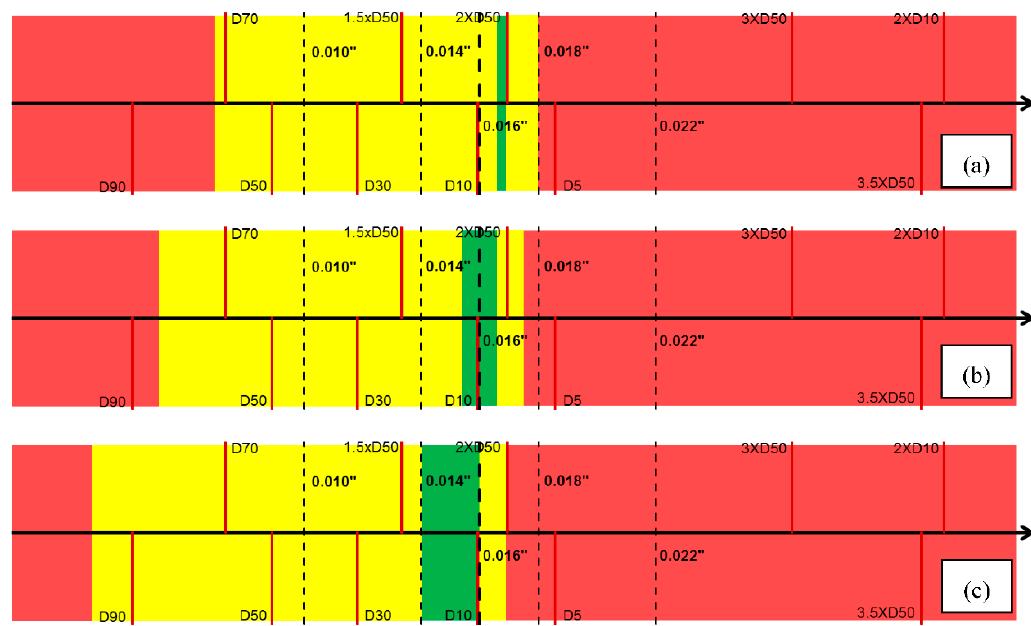
Figure 15. TLS of DC-III in the normal condition for SPF 120 ( a ), SPF 168 ( b ), and SPF 216 ( c ).